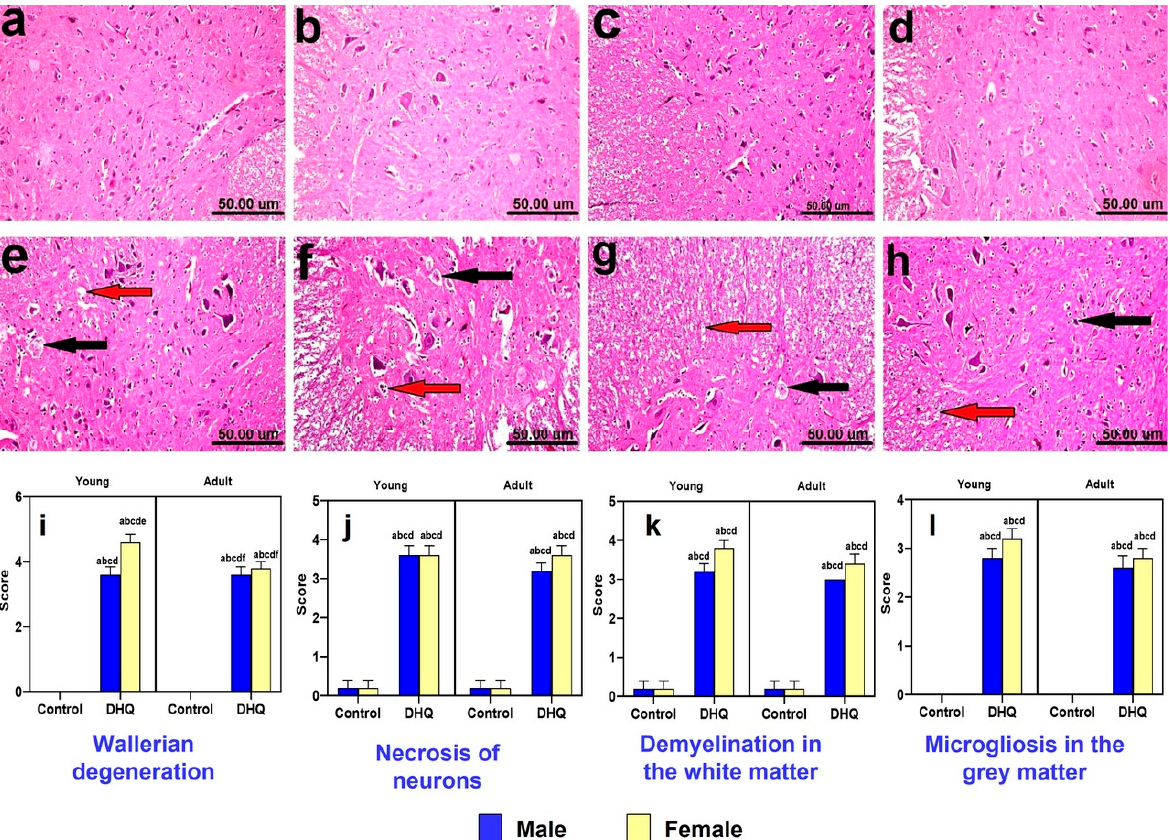
Figure 6. Histological hematoxylin and eosin-stained sections from spinal cords of ( a – d ) control rats, ( a ) young male, ( b ) young female, ( c ) adult male, and ( d ) adult female, showing the normal histological structure. ( e ) DHQ young male showing Wallerian degeneration (black arrow), demyelination (red arrow), and diffuse microgliosis in the gray matter. ( f ) DHQ young female showing marked Wallerian degeneration (black arrows), necrosis, and karyorrhectic nuclear changes with microgliosis (red arrow) and central chromatolysis of motor neurons (arrowhead). ( g ) DHQ adult male showing Wallerian degeneration (black arrow) and severe demyelination (red arrow) in the white matter. ( h ) DHQ adult female showing necrosis of neurons with diffuse gliosis (black arrow) and demyelination (red arrow) (scale bar 50 um). Graphical representation of histopathological scores for ( i ) Wallerian degeneration, ( j ) necrosis of neurons, ( k ) demyelination in the white matter, and ( l ) microgliosis in the gray matter. Each bar with a vertical line represents the mean ± S.D. of 5 rats per group. a vs. control young male, b vs. control young female, c vs. control adult male, d vs. control adult female, e vs. treated young male, and f vs. treated young female using three-way ANOVA followed by Tukey’s post hoc test; p < 0.05. DHQ;